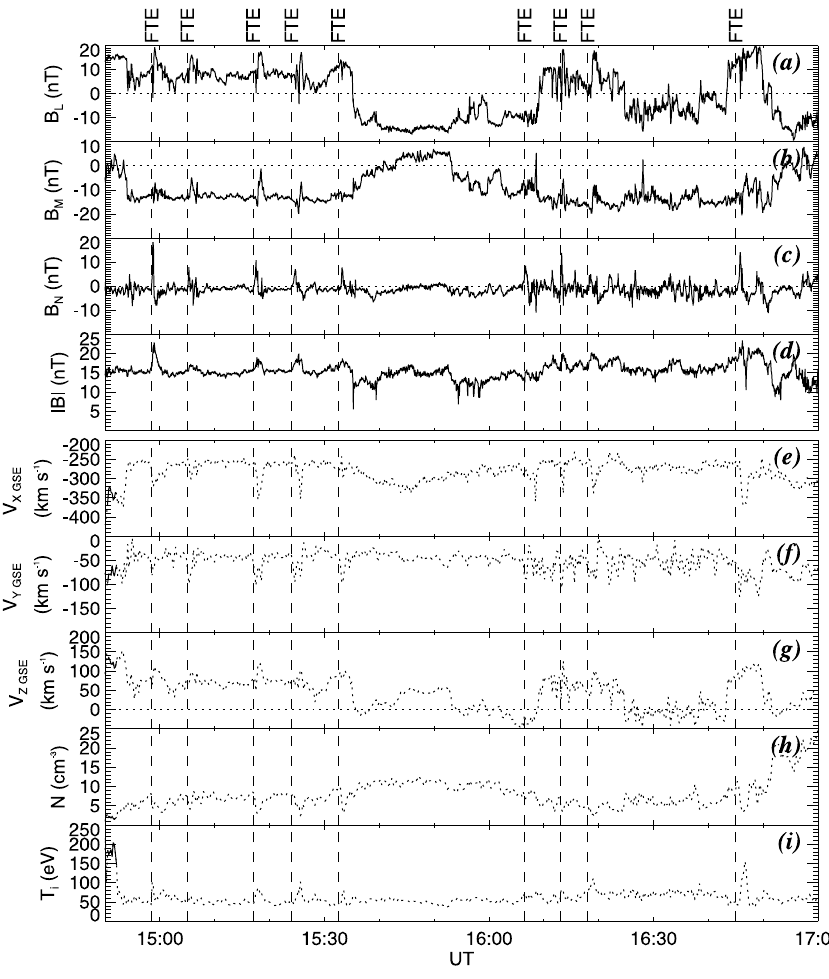
Fig. 5. (a) B l , (b) B m , (c) B n boundary normal (Russell and Elphic, 1978) magnetic field components, and (d) the magnetic field strength from Geotail. The boundary normal unit vector relative to GSM is [ − 0 . 277 , 0 . 927 , 0 . 253]. (e) – (g) The plasma velocity in the ˆ x , ˆ y , and ˆ z GSM directions, respectively, (h) the plasma concentration, and (i) the ion temperature from the LEP-SW instrument on